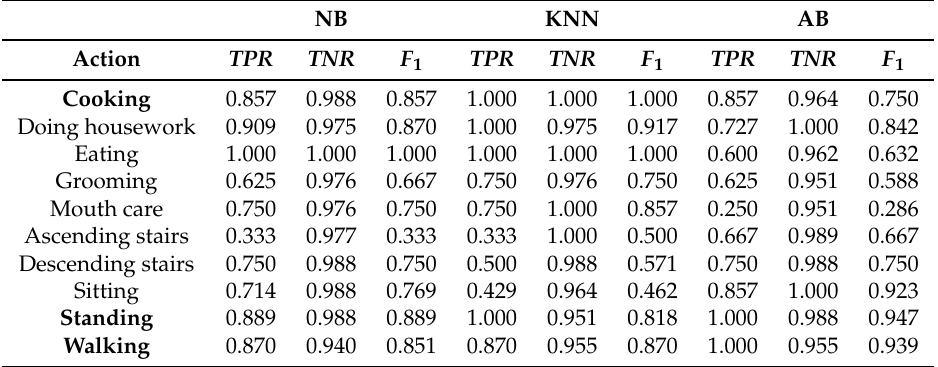
Table 4. Classification results for each action using High-level features extracted with both static and dynamic approaches.KNN:K-nearestneighbours, NB:NaiveBayes, andAB:AdaBoostinferencealgorithms.